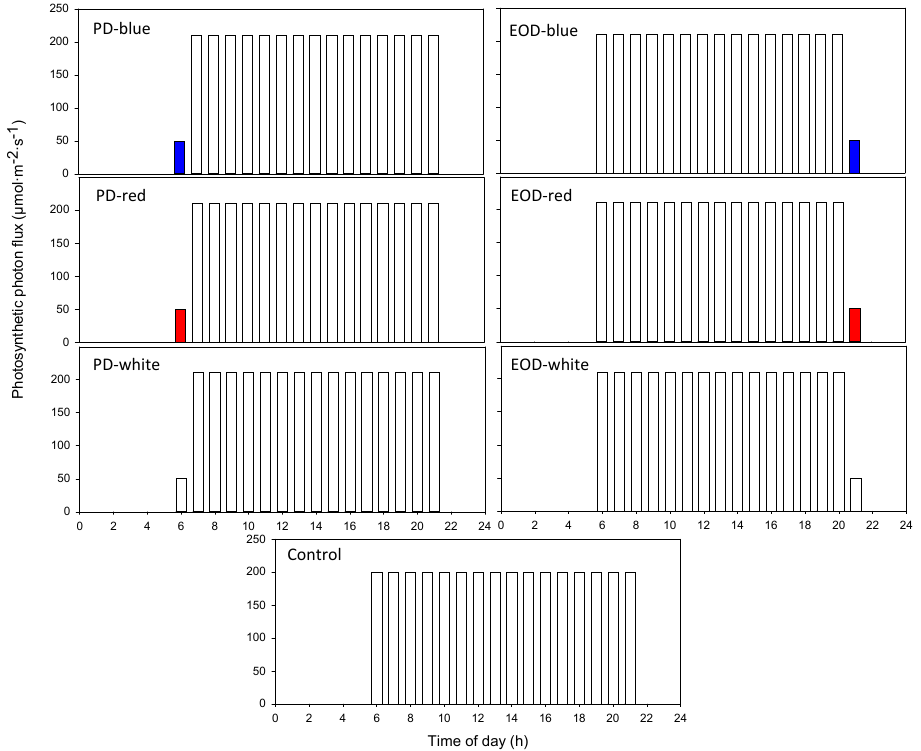
Figure 1. Illustration of the light quality, intensity, and photoperiod used throughout the study. PD = pre-dawn; EOD = end-of-day.